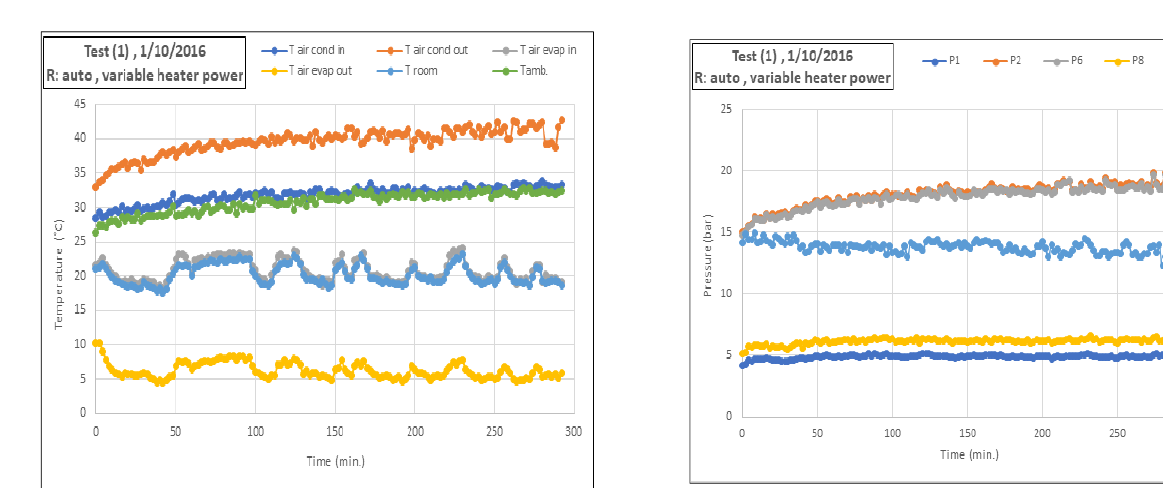
Fig. 9c. Refrigerant temperature with time for test3.